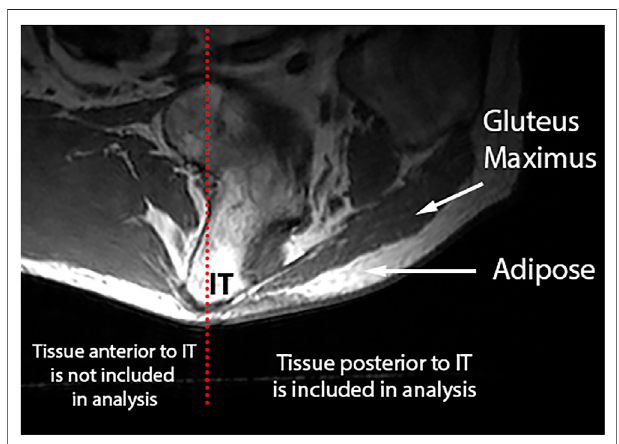
FIGURE 2 | IMAT is calculated using the gluteus maximus and SubQF intensities posterior to the ischial tuberosity.